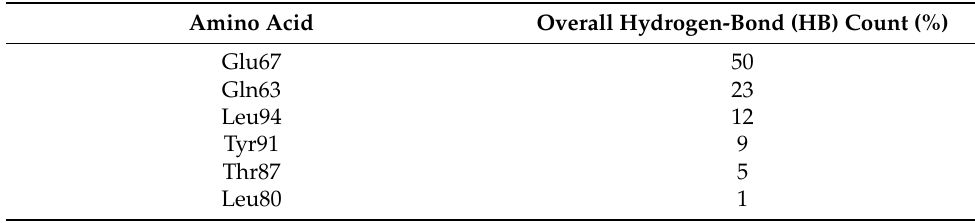
Figure 6. Dimer conformations representing the state of QacR during MD simulations for: ( a ) QacR:CPC at 200 ns (right; inset: the CPC ligand enlarged), ( b ) QacR: Py-C 14 at the beginning (starting snapshot, left) and during the last 200 ns (right; inset: Py-C 14 ligand enlarged). Protein is given in orange (new cartoon representation), with the ligands shown in the licorice. Table 4. Contribution of all the amino acid residues forming hydrogen-bonds (HB) with Py-C 14 to the overall Py-C 14 — protein HB count.